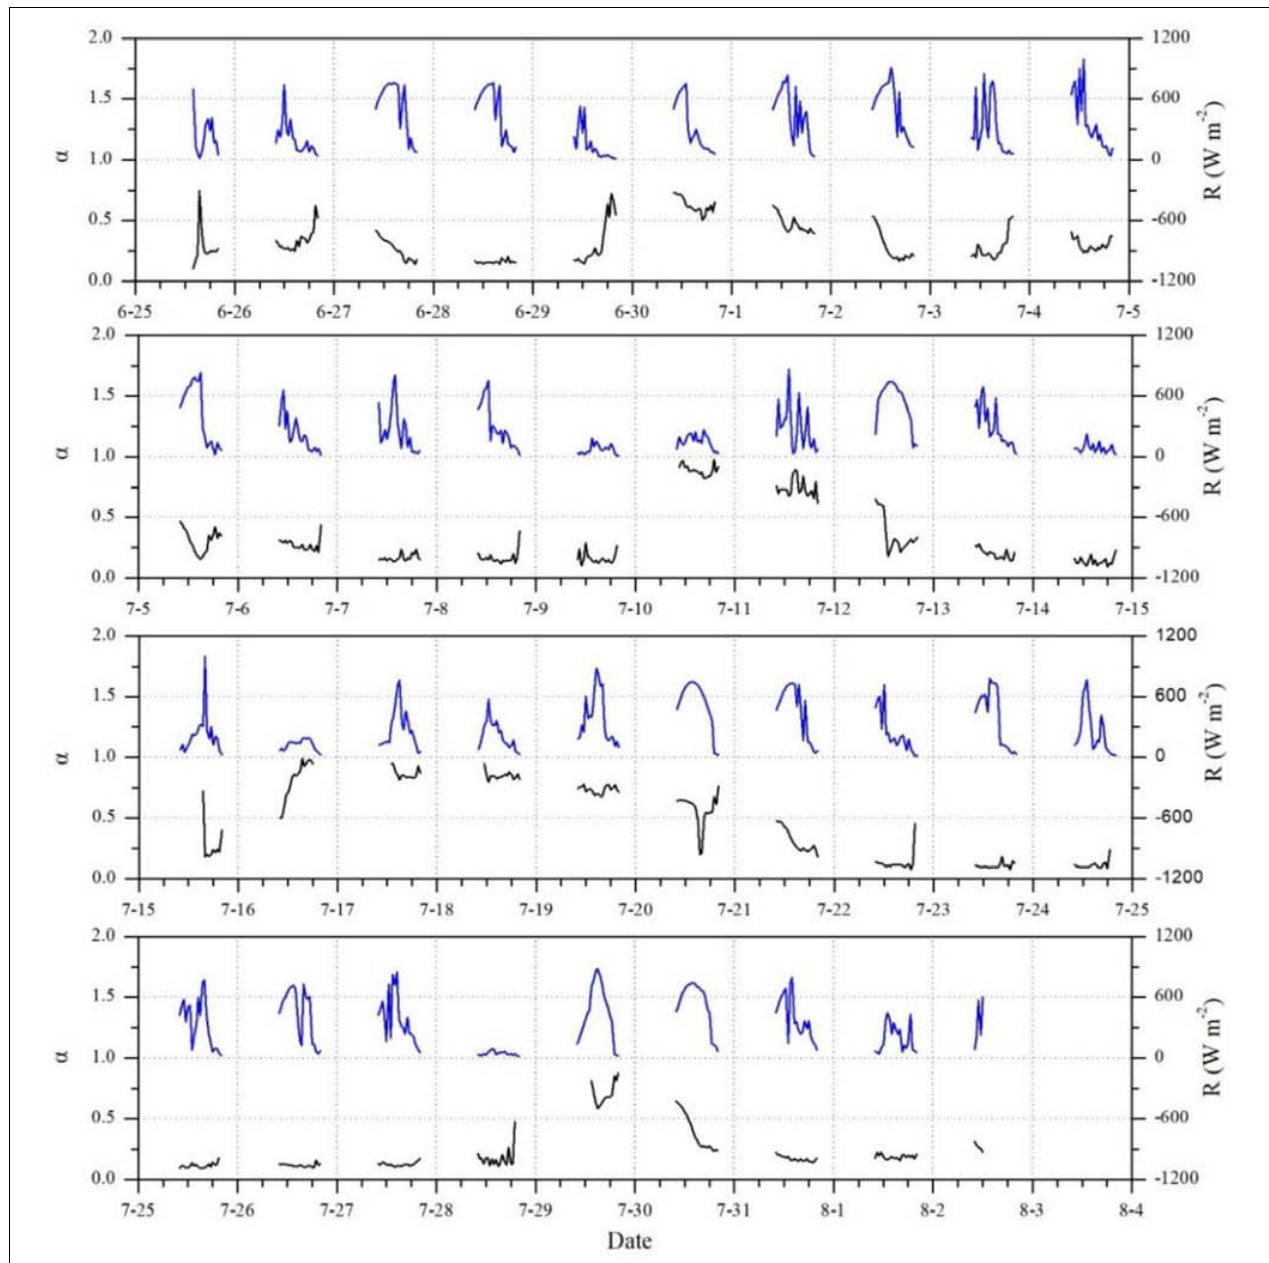
FIGURE 2 | Half-hourly albedo ( α , black line) and incoming shortwave radiation (R, blue line) records by AWS between 26 June and 2 August 2007. Half-hourly values with solar zenith angle > 65 ◦ were not considered.